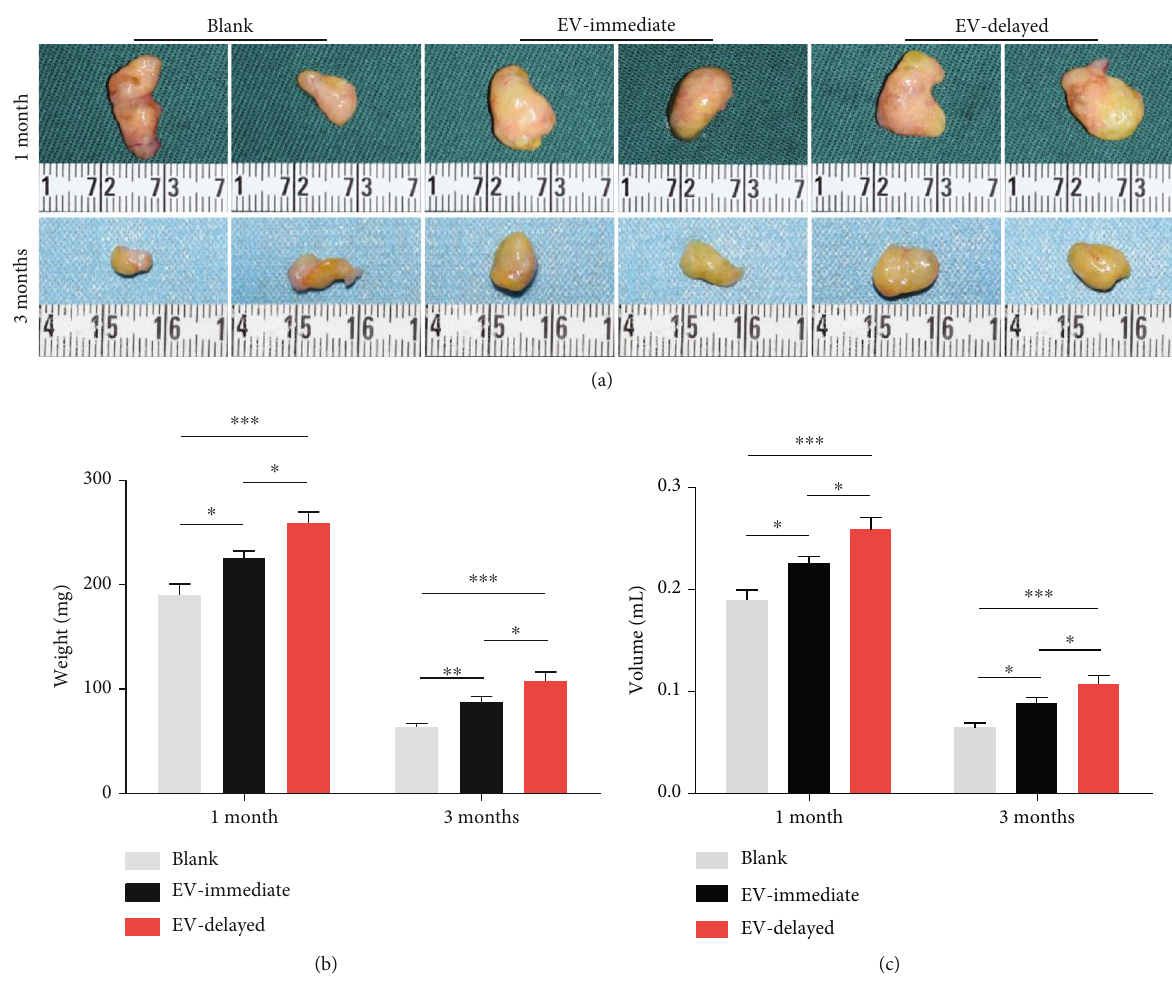
Figure 4: In vivo fat grafting with delayed injection of ADSC-EVs. (a) Photographs of fat grafts taken from di ff erent groups of nude mice after 1 and 3 months. Quantitative analysis of (b) weight and (c) volume from mice after di ff erent treatments. n = 8 for both. ∗ P < 0 : 05 and ∗∗∗ P < 0 : 001